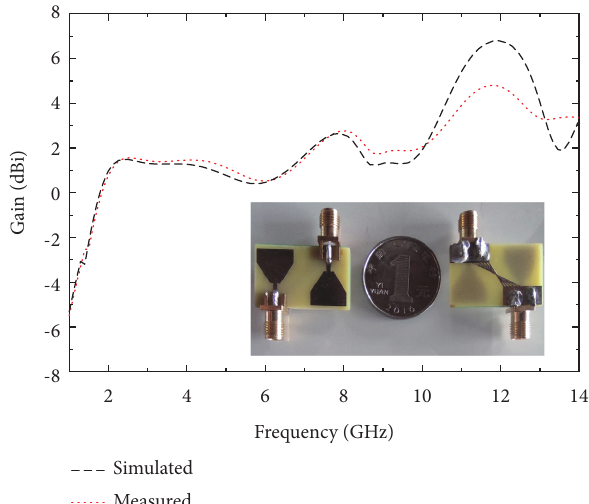
Figure 18: Gain graph of two-port antenna simulation and